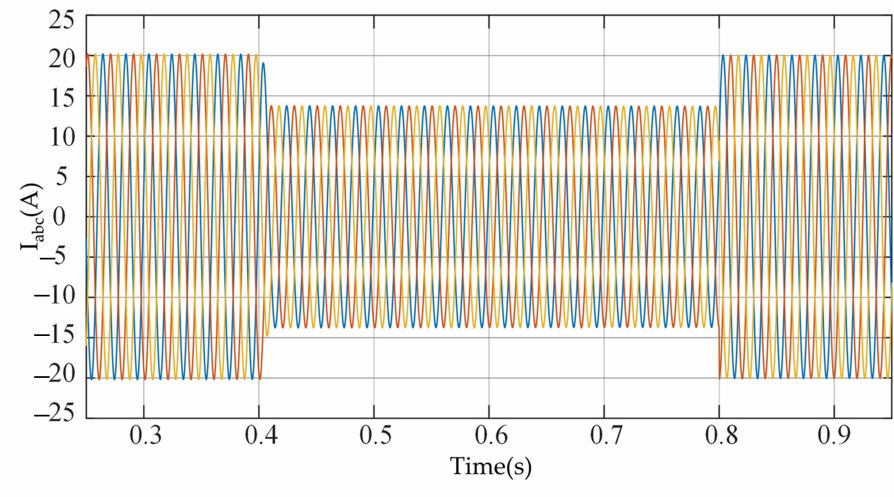
Figure 13. Three-phase current variation situation result of case-2.